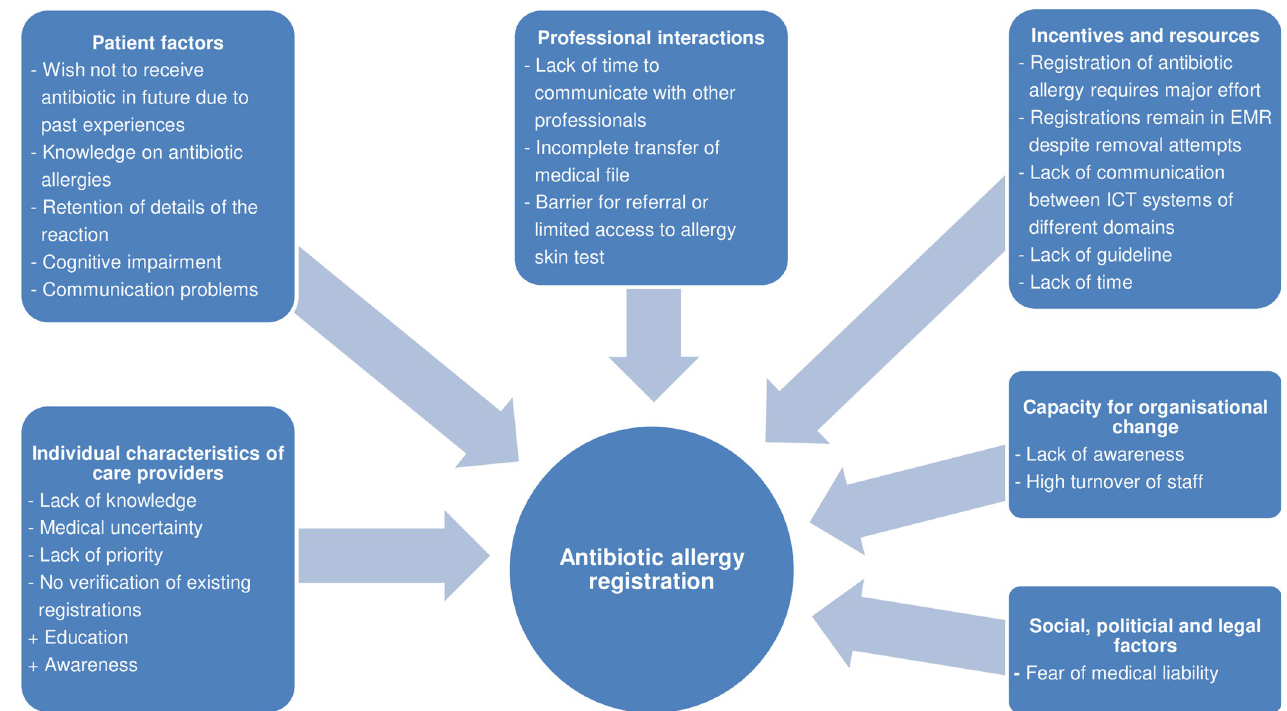
Fig 1. Determinants of antibiotic allergy registration. + = facilitator;— = barrier; EMR: Electronic Medical Record; ICT: Information Communication Technology.